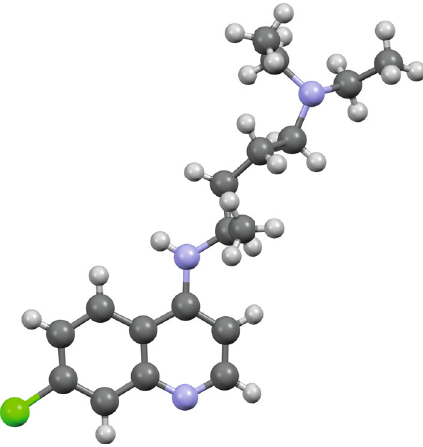
Figure 4: Molecular structure of Chloroquine.